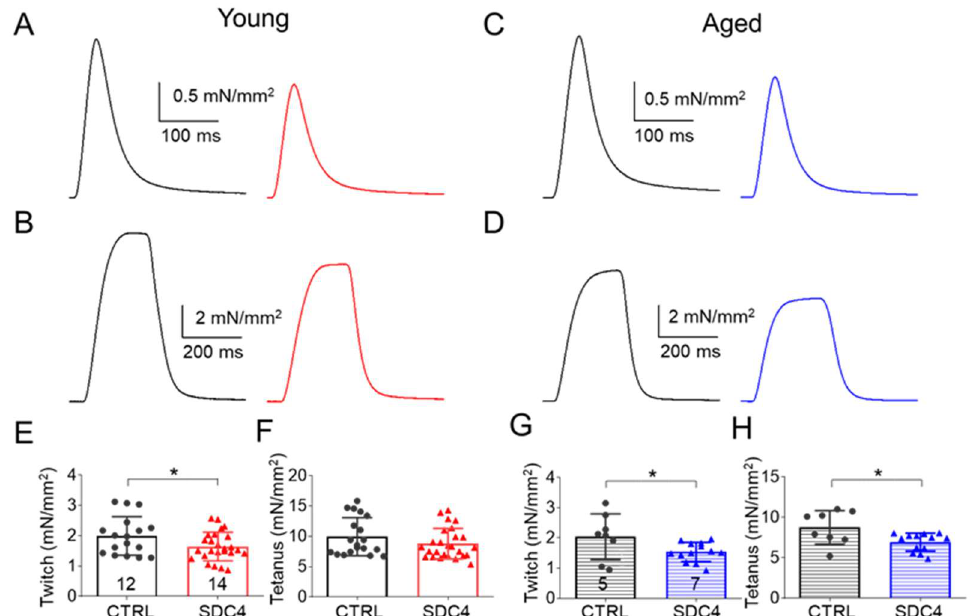
Figure 1. Representative ex vivo twitch ( A , C ) and tetanic ( B , D ) force on EDL muscle from young ( A , B ) and aged ( C , D ) CTRL (black) and SDC4 (red, blue) mice stimulated at 1 or 200 Hz, respectively, at room temperature (24 °C). Average twitch ( E , G ) and tetanic ( F , H ) force normalized to the cross-sectional area of the muscle. The numbers in the columns indicate the number of animals studied. * shows a significant difference from the age-matched CTRL at p < 0.05.